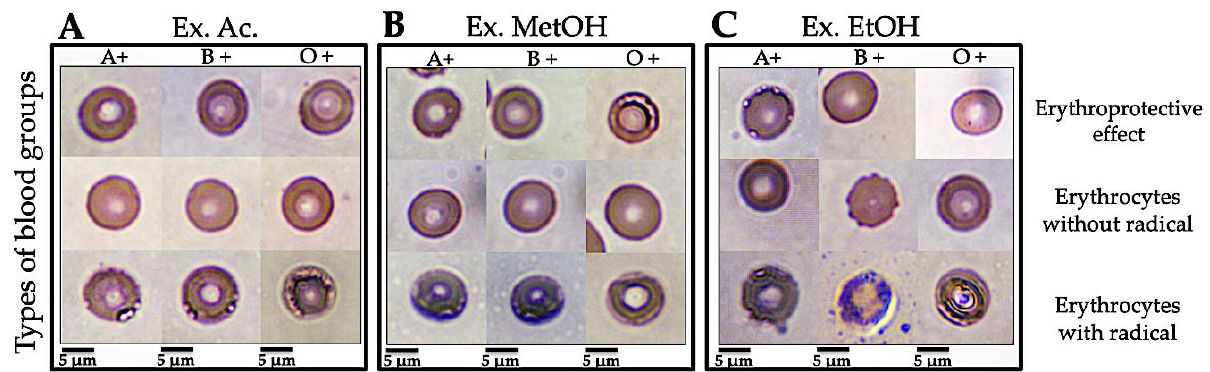
Figure 1. Micrographs of human erythrocytes (100×). Use of red blood cell membranes to evaluate the protective effect against oxidative damage from N. incerta extracts in different blood group types (ABO system). Morphological change seen in micrography is caused by free-radical-induced hemolysis (using AAPH molecule as a free radical generator). ( A ) Protective effect of the acetone extract (Ext. Ac.) of N. incerta on ABO blood groups. ( B ) Protective effect of the methanolic extract (Ext. MetOH.) of N. incerta on ABO blood groups. ( C ) Protective effect of the ethanolic extract (Ext. EtOH.) of N. incerta on ABO blood groups. Barr = 5 μm.